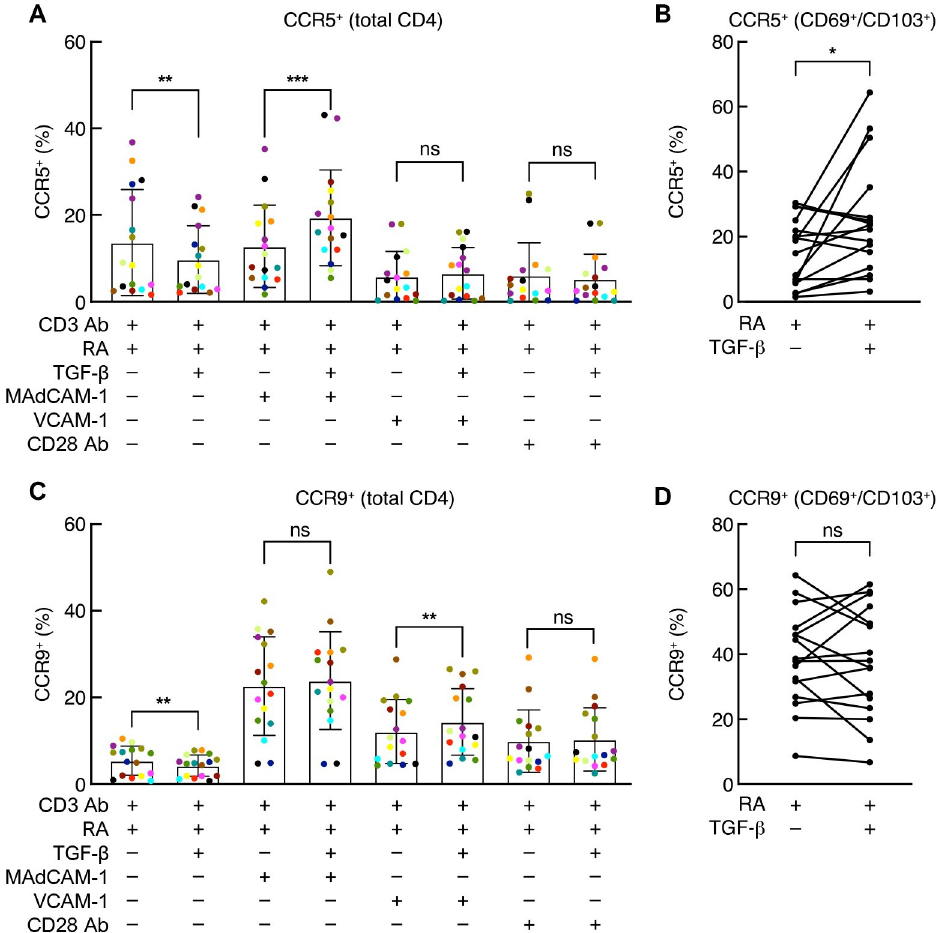
Fig 5. TGF- β effect on CCR5 and CCR9 expression. Flow-cytometric analysis of CCR5 and CCR9 expression on total CD4 + T cells ( A and C ) or CD69 + /CD103 + CD4 + T cells ( B and D ) costimulated with MAdCAM-1 + RA, VCAM-1 + RA, or CD28 Ab + RA, in the absence or presence of TGF- β , as indicated (n = 16) ( � : P < 0.05, �� : P < 0.01, ��� : P < 0.001, two-tailed t test).